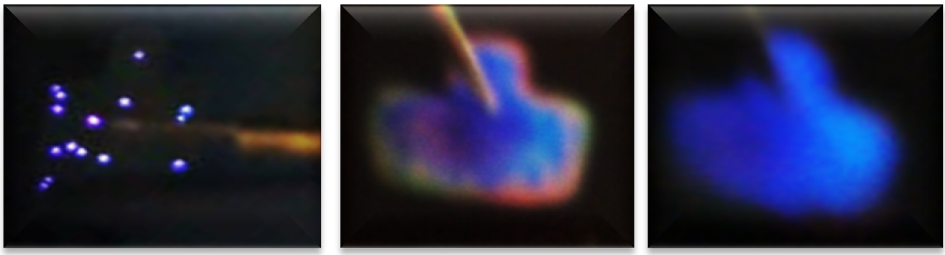
Figure 11. Progress of the blue emission of the complete area.